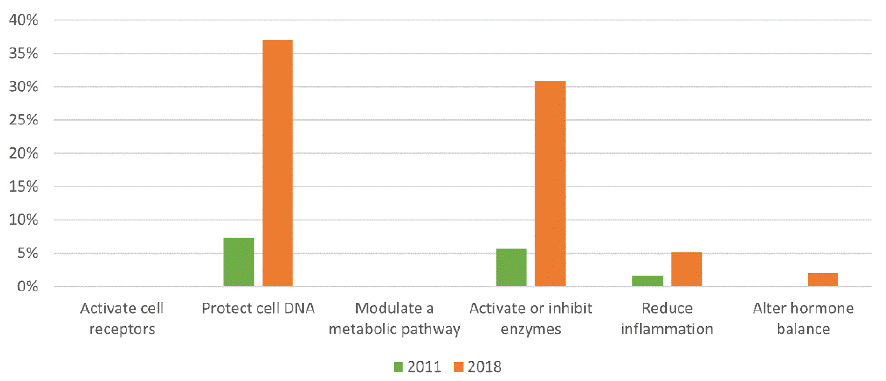
Figure 2. Relative amount of botanical ingredients classified by anti-aging